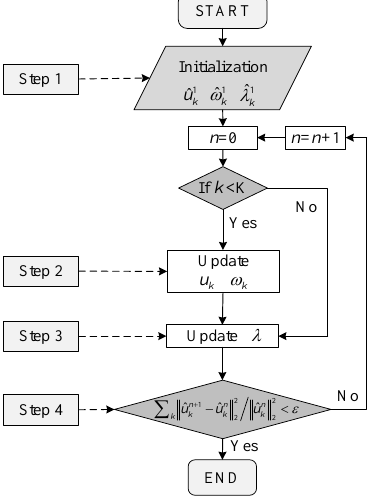
Figure 1. Flowchart of the variational mode decomposition (VMD) algorithm.